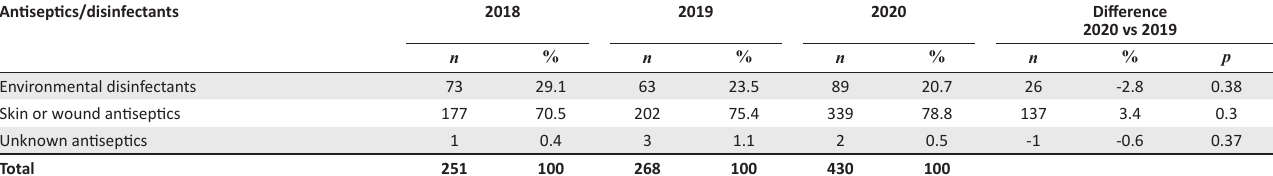
TABLE 2-A1: Antiseptic and Disinfectant exposures received by the Poisons Information Helpline of the Western Cape in the first six months of the COVID-19 pandemic and similar periods during 2018 and 2019. Antiseptics/disinfectants